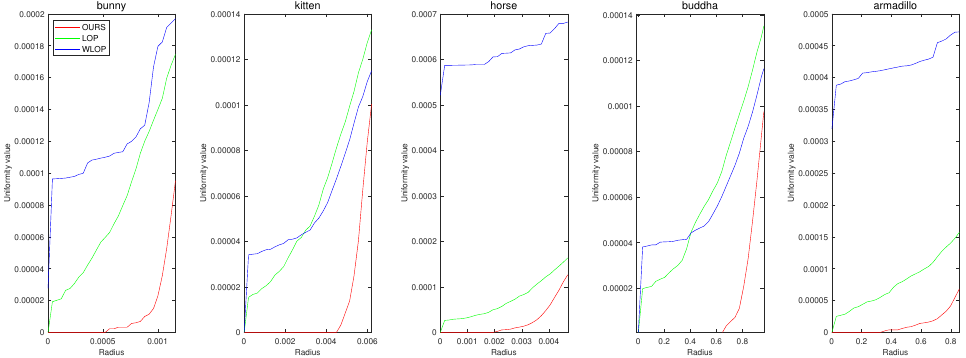
Figure 10. Quantitative results for the tangential noise cases with resampling ratio 0.5. Each column represents different input data (first column: Horse; second column: Bunny; third column: Kitten; fourth column: Buddha; and fifth column: Armadillo).